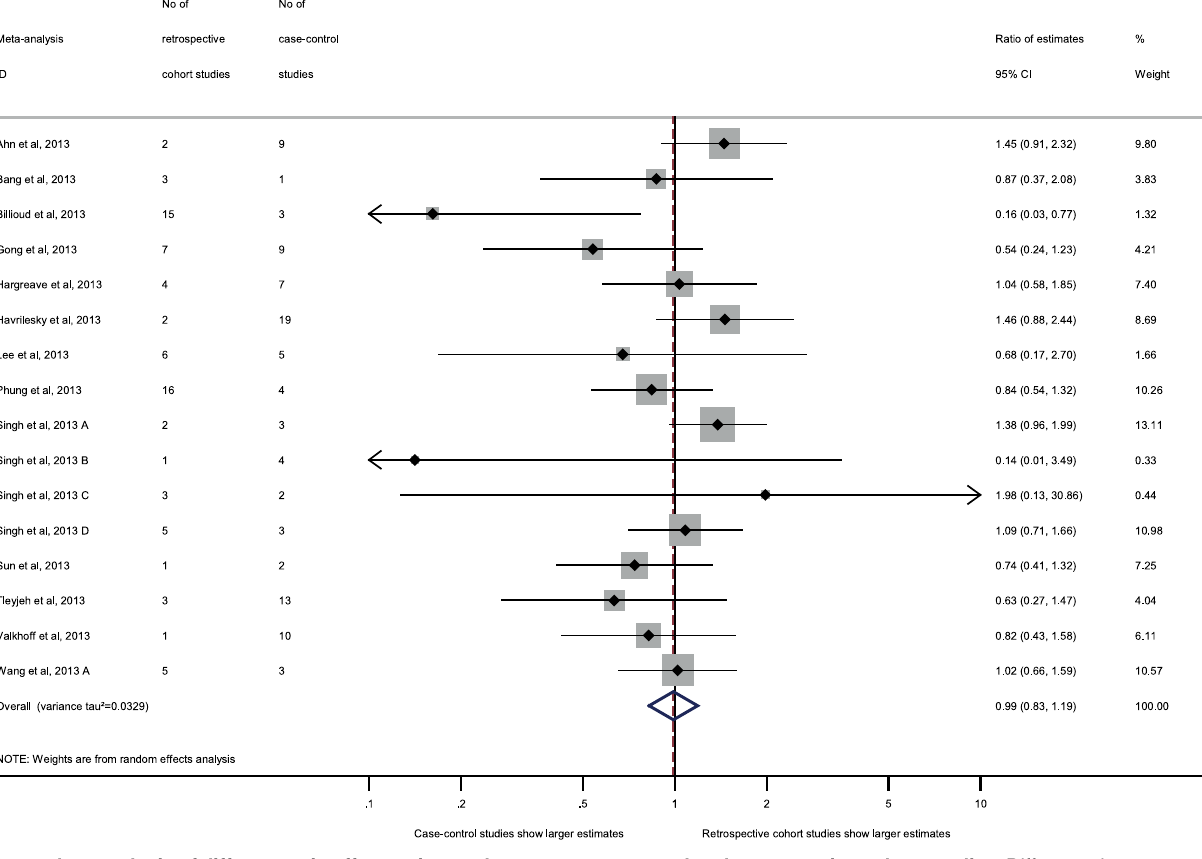
S2 Table. Characteristics of included meta-analyses.